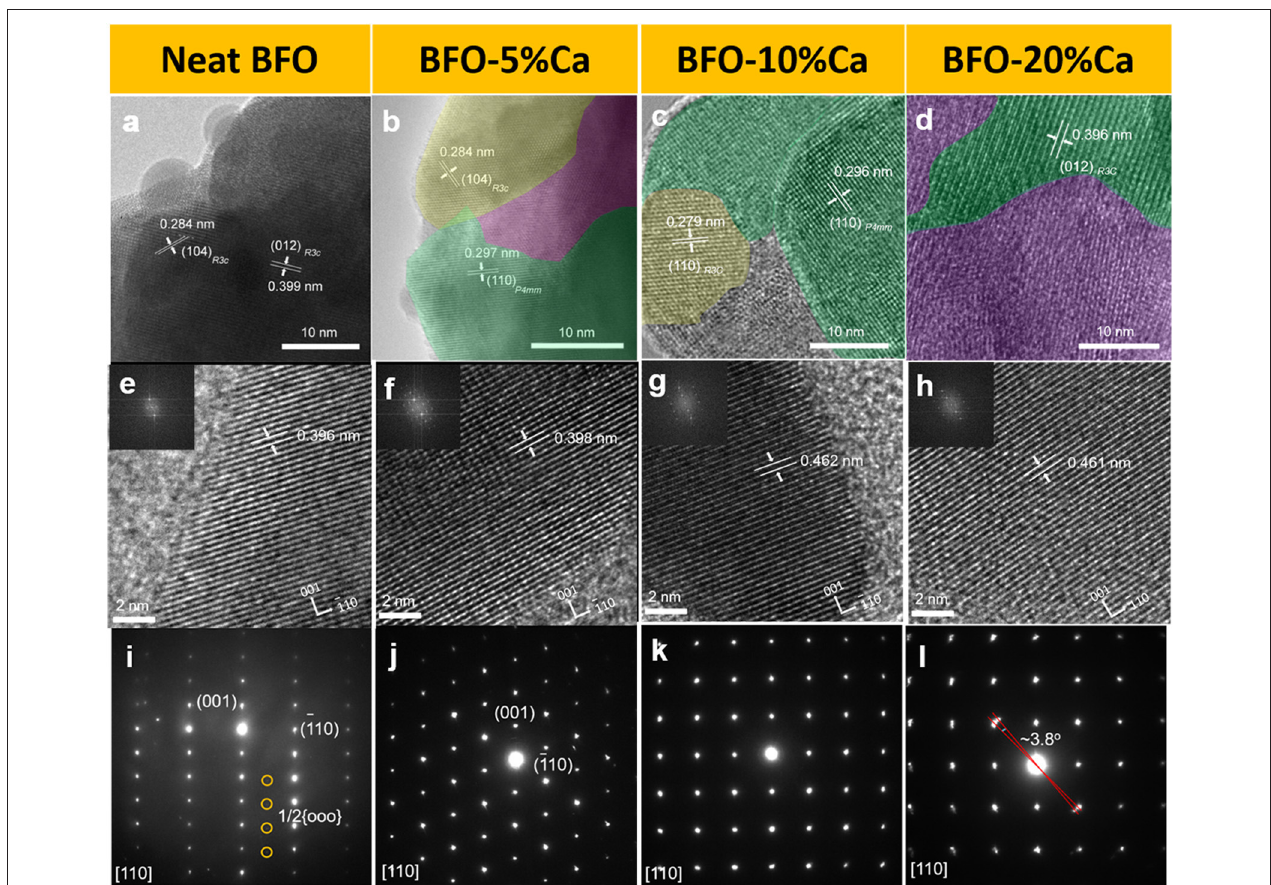
FIGURE 3 | HRTEM images of (a–h) neat BFO and BFO with different doping amounts of Ca 2 + ions (inset: FFT patterns); (i–l) SAED patterns along the [110] zone axis direction.